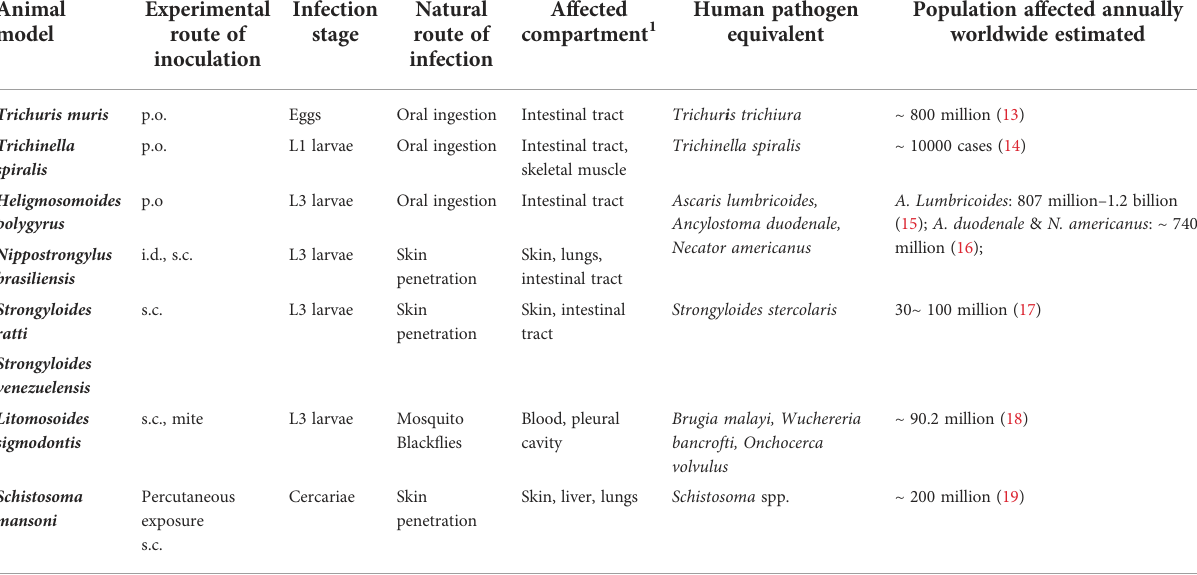
TABLE 1 Experimental animal models of helminth